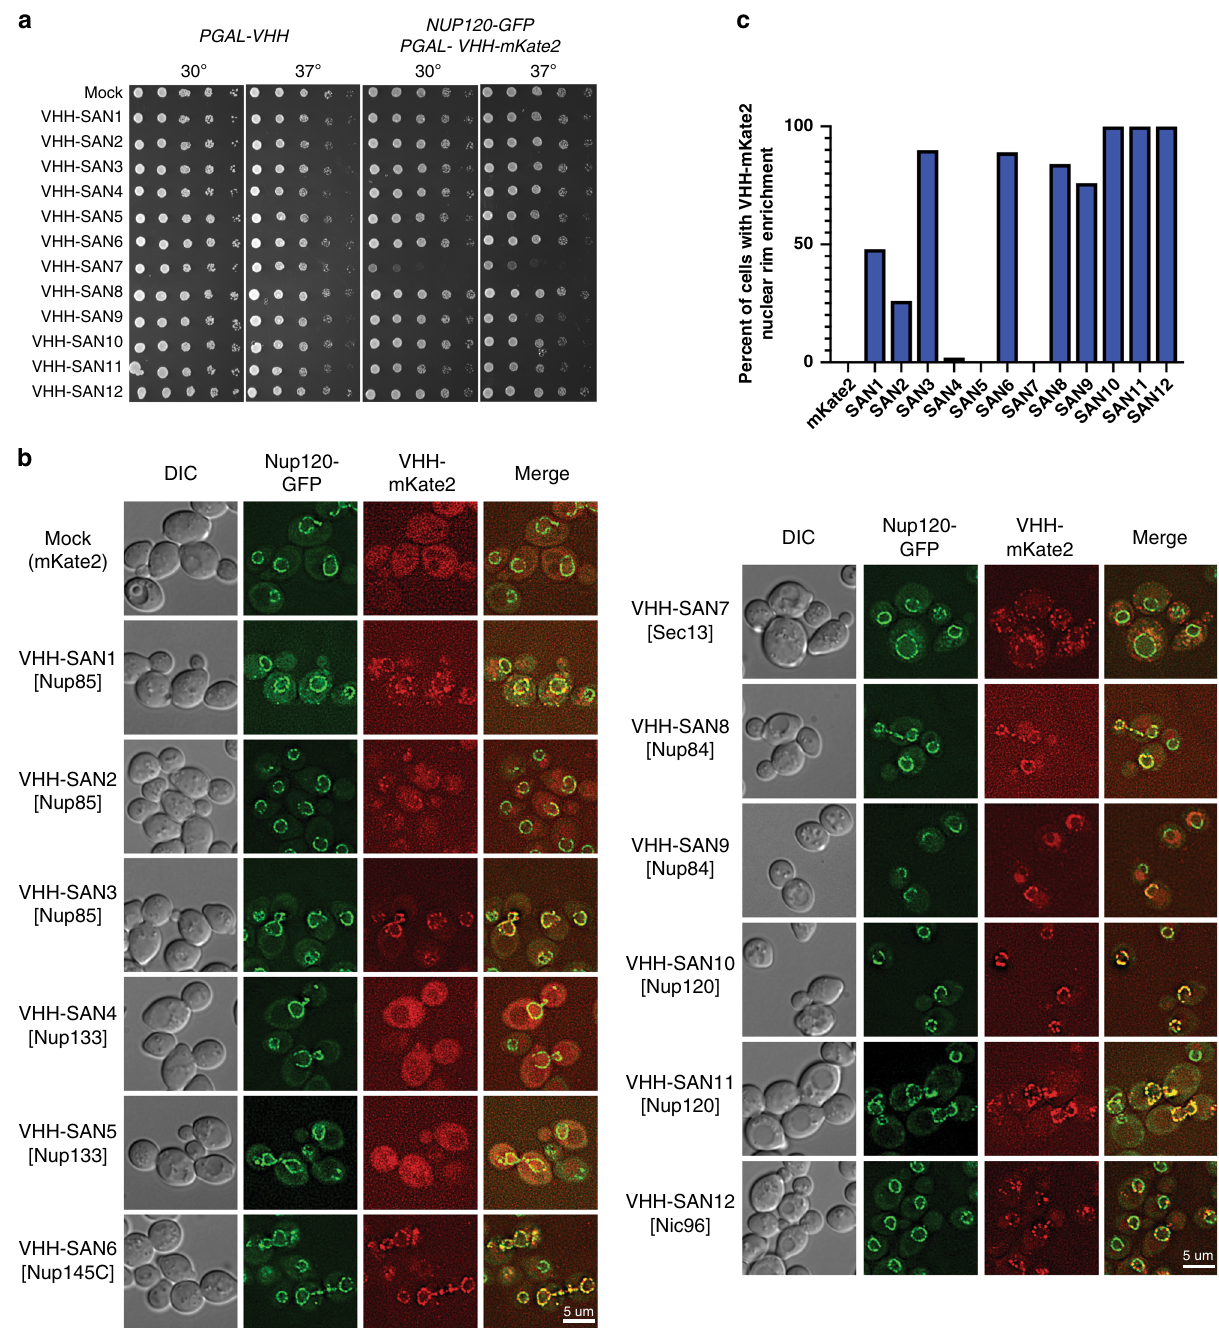
Fig. 6 Expression of nanobody-mKate2 fusions in vivo. a Spot assays for nanobody and nanobody-mKate2 expression. Strain construction is indicated at the top of the fi gure, along with assay temperature. Pictures were taken after 48 h on 2% galactose containing agar media. Mock speci fi es mKate2 expression alone. b Fluorescence images of cells expressing endogenously tagged Nup120-GFP and plasmid expressed NUP120- VHH-mKate2 in DIC, GFP, and far-red channels with a merged overlay. Target of each nanobody is listed in brackets. Scale bar: 5 μ M. c Percent of cells with VHH-mKate2 exhibiting nuclear rim enrichment, n = 50 cells per strain over one